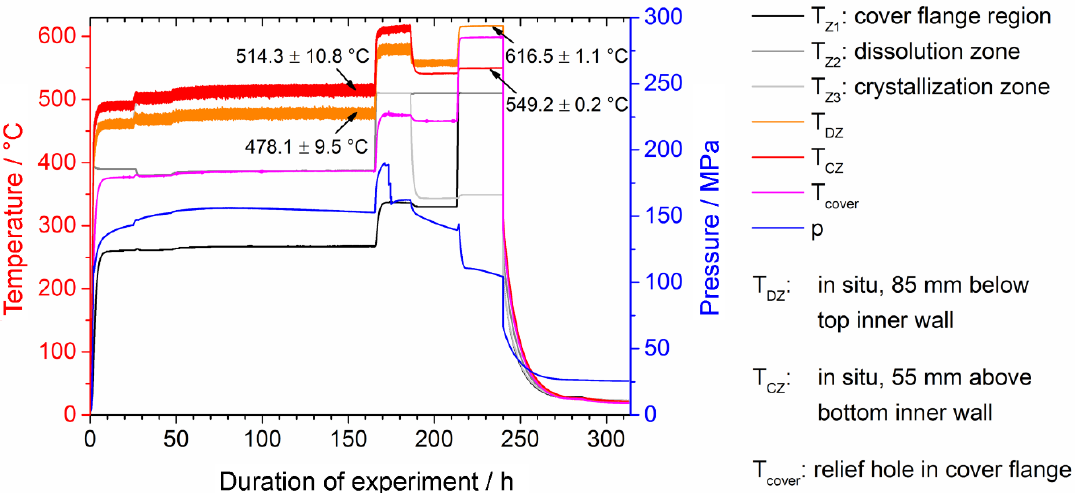
Figure 8. Temperature and pressure data of experiment B over time. The width of temperature fluctuations is given as a plus-/minus-range that follows the average value. For an illustration of the locations of measurement see Figure 1. Reprinted from [21].